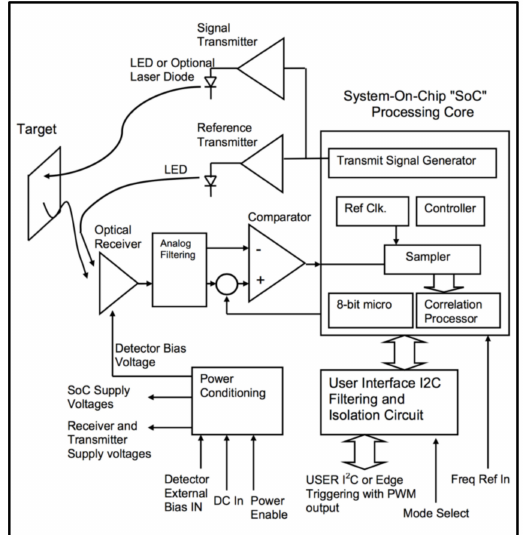
Figure 16. Architecture of LiDAR Lite V2